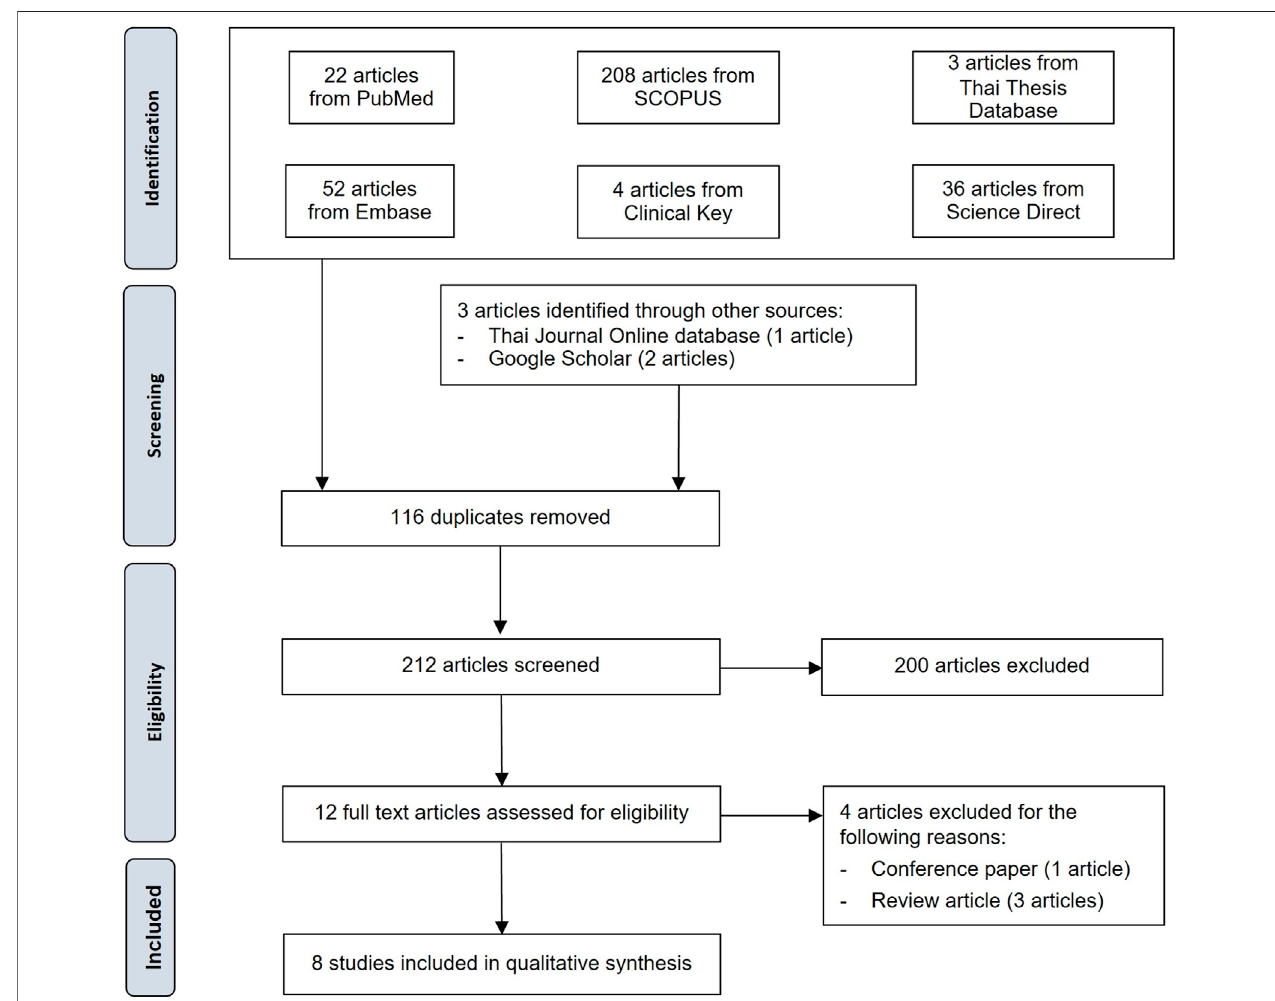
FIGURE 1 | PRISMA fl ow diagram for the study selection